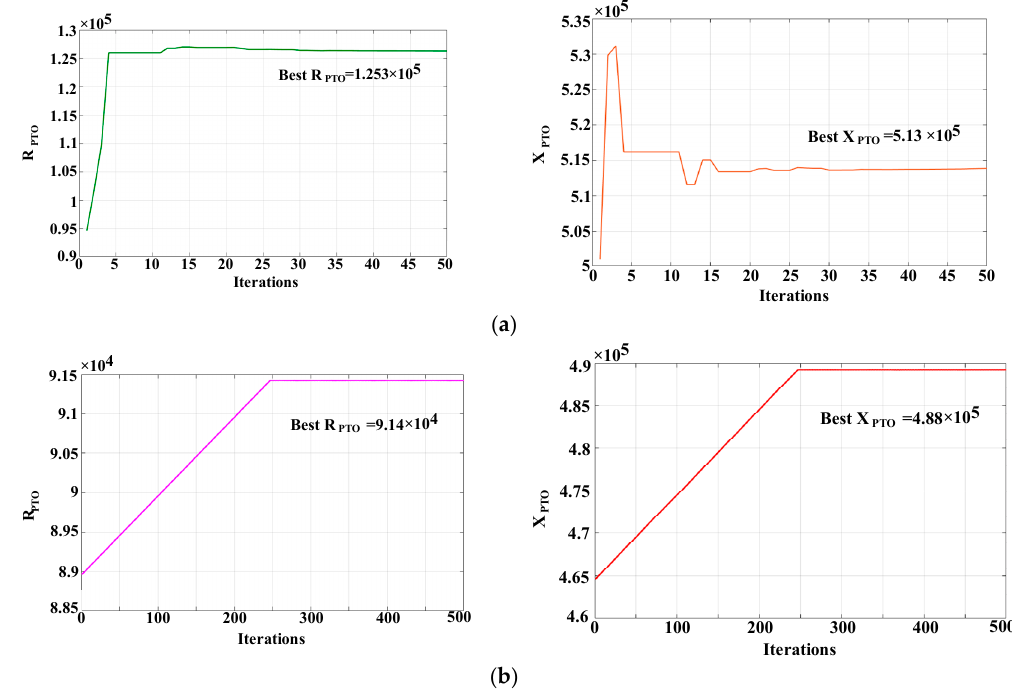
Figure 8. Simulateddampingcoefficientandstiffnesscoefficientobtainedby( a )FPA,( b )hill-climbingmethod. Figure 8. Simulated damping coefficient and stiffness coefficient obtained by ( a ) FPA, ( b ) hill-climbing method.